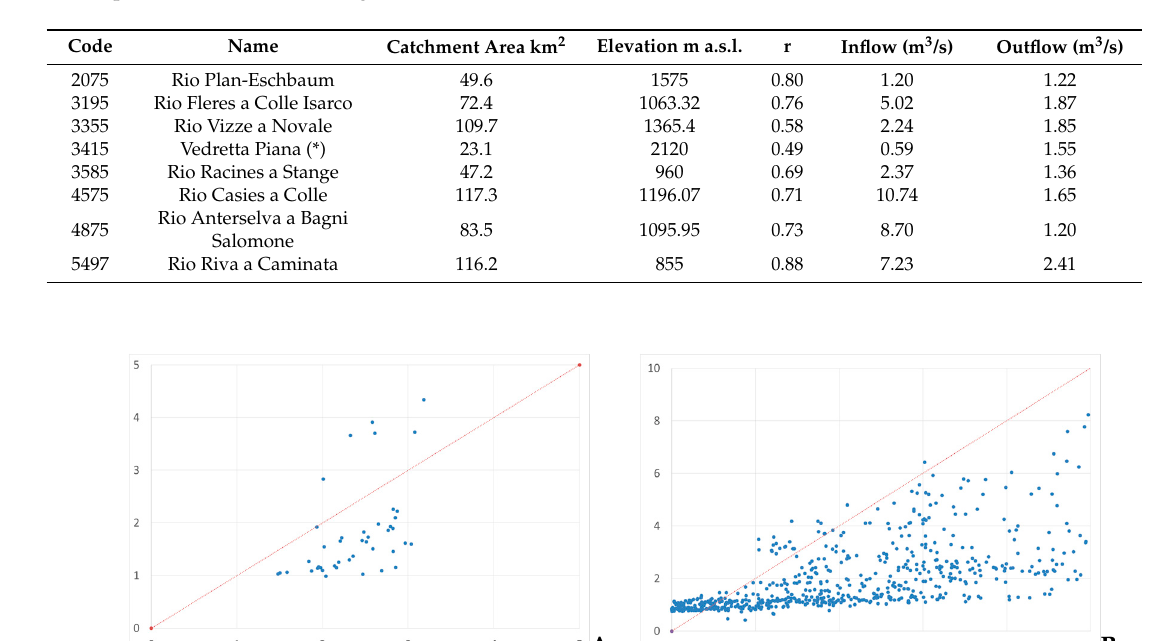
Table 4. Discharge measurement stations used for the testing of snowmelt. The correlation coefficient r is always with p << 1.0E − 05, except for Vedretta Piana where p = 4.6E − 05. Inflow is the average of daily precipitation flows (precipitation times catchment area) during the months of November to May; outflow is the corresponding measured discharge at the catchment outlet. (*) For Station 3415, outflow higher than inflow may be a consequence of the paucity of measurements, not necessarily representative of the average.